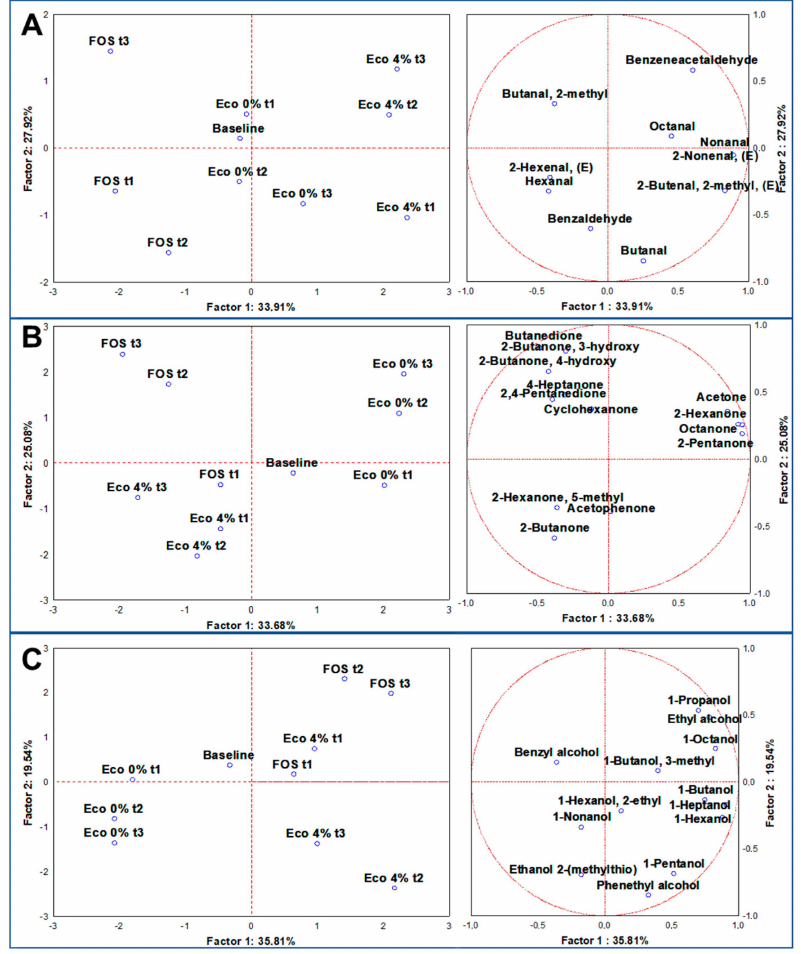
Figure 2. PCAs of the volatilome sorted by chemical classes of significative (ANOVA p < 0.05) VOCs, including the baseline and three different timepoints (t1 = 5 h; t2 = 10 h; t3 = 24 h). ( A ) = Aldehydes; ( B ) = Ketones; ( C ) = Alcohols. Left-side diagrams are for PCAs of cases, while right-side diagrams are for PCAs of